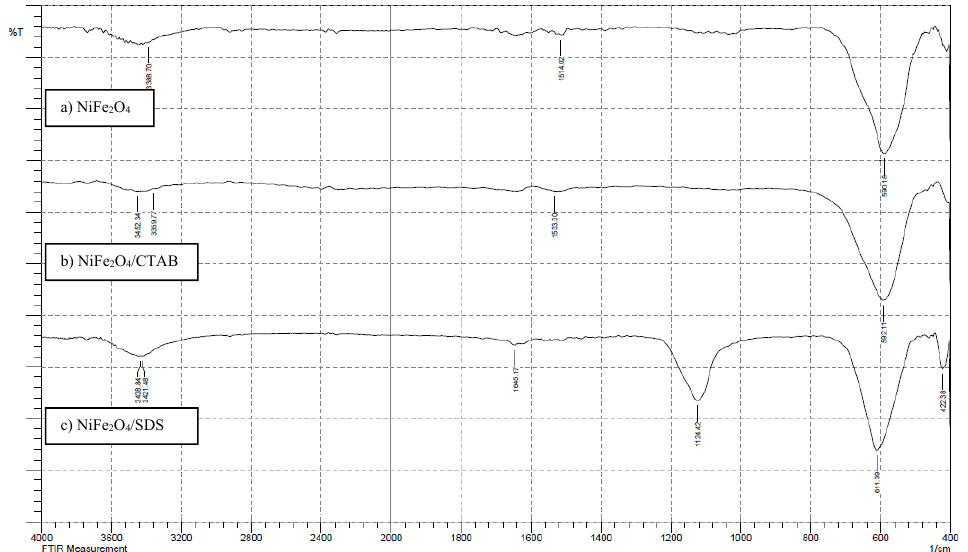
Fig. 4. FT-IR spectra of NiFe